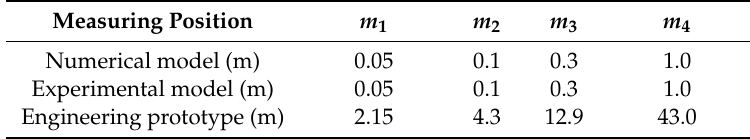
Table 1. The parameter selection of measuring